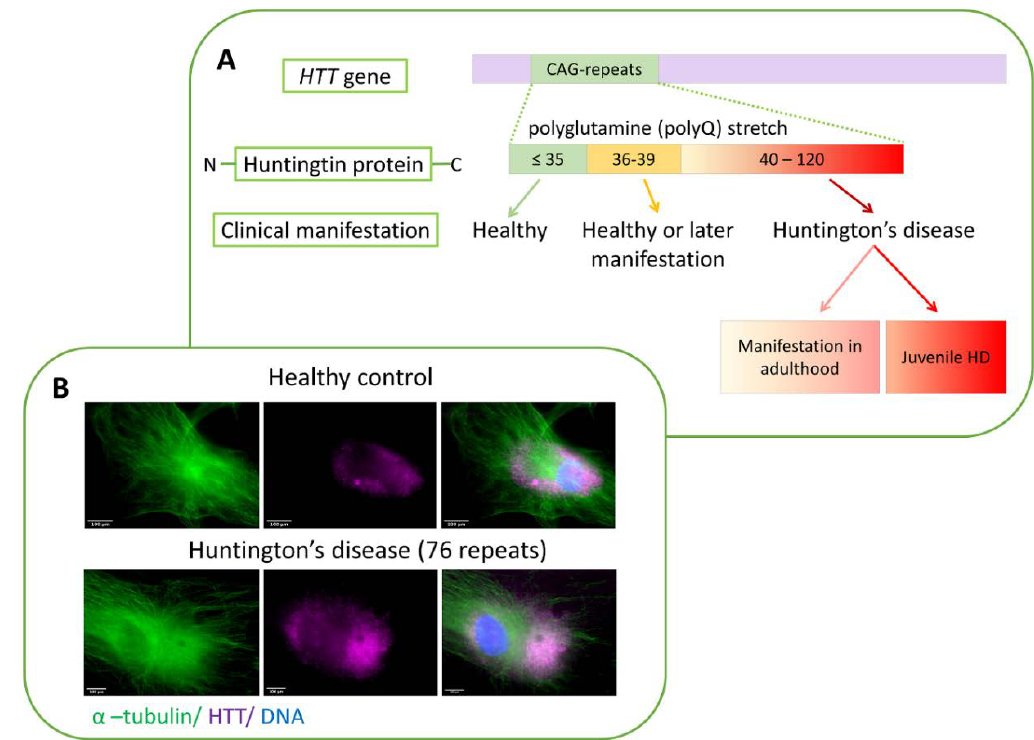
Figure 2. ( A ) The correlation of the number of CAG repeats in the HTT gene with the clinical manifestation of HD. The number of repeats ≤ 35 is normal; from 36 to 39 may not phenotypically manifest (or lead to the development of HD at a later age); from 40 upwards in 100% of cases causes HD. Hence, the age of disease onset and the severity of clinical symptoms depend on the number of CAG repeats according to the inverse correlation principle. ( B ) Immunocytochemical detection of HTT in the skin fibroblasts of healthy donors and patients with HD. Localization of HTT in the cells of a healthy donor (top panel) and a patient with HD (bottom panel).